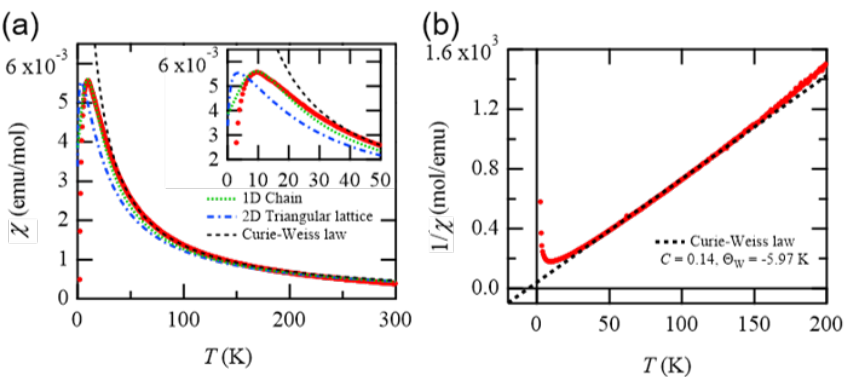
Figure 3. Temperature dependence of ( a ) magnetic susceptibility. The blue, green, and black dotted lines represent the fitting to the 2D triangular model, 1D chain model, and Curie–Weiss law, respectively. ( b ) 1/χ plot.